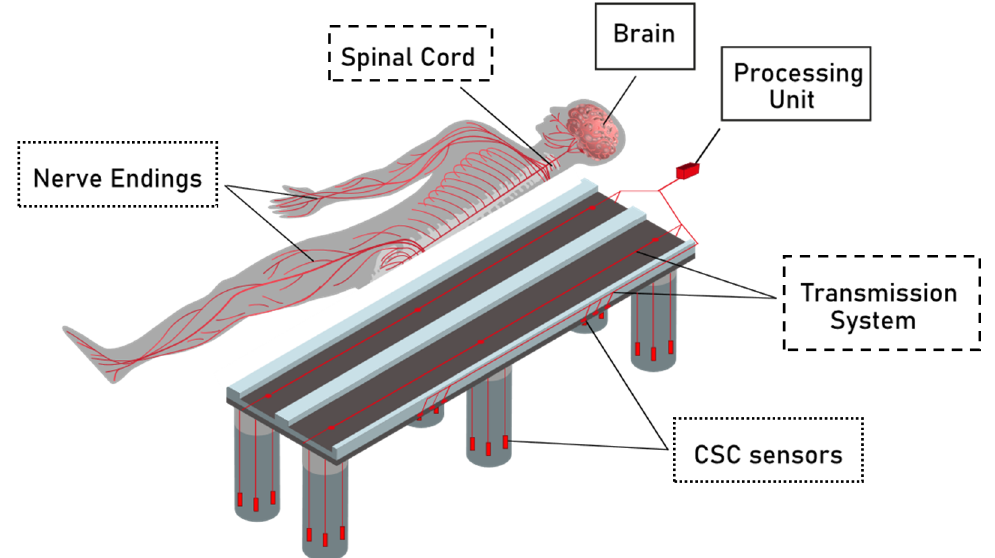
Figure 1. Schematic illustration of a biomimetic CSC-based civil SHM system.